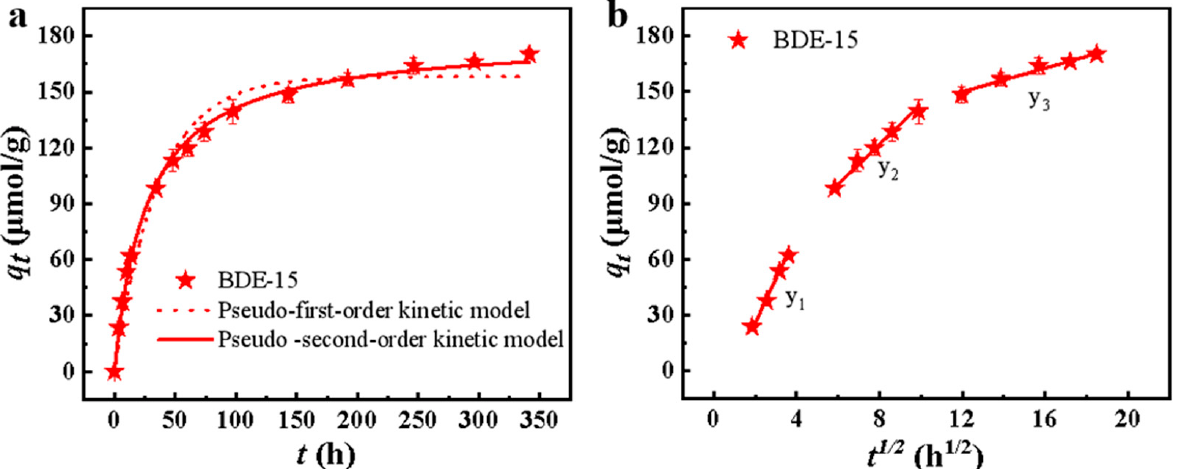
Figure 1. SEM ( a 1 , a 2 ), EDS ( b 1 , b 2 ), N 2 adsorption–desorption isotherms ( c ) and pore size distribution ( d ) images of GAC.